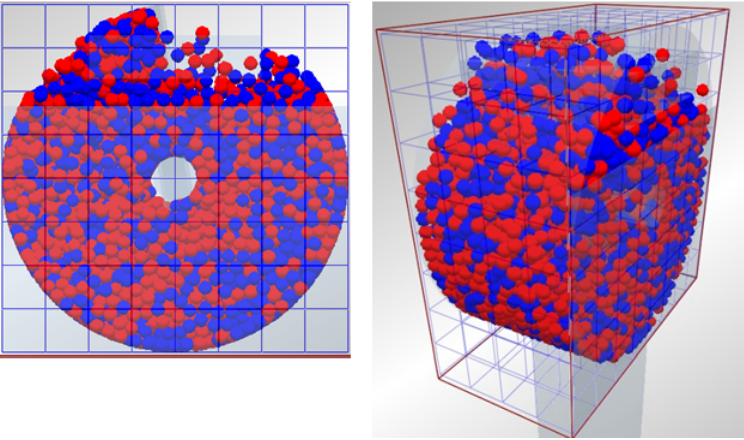
Figure 9. Discrete Element Method (DEM) simulation of particles mixing in a periodic